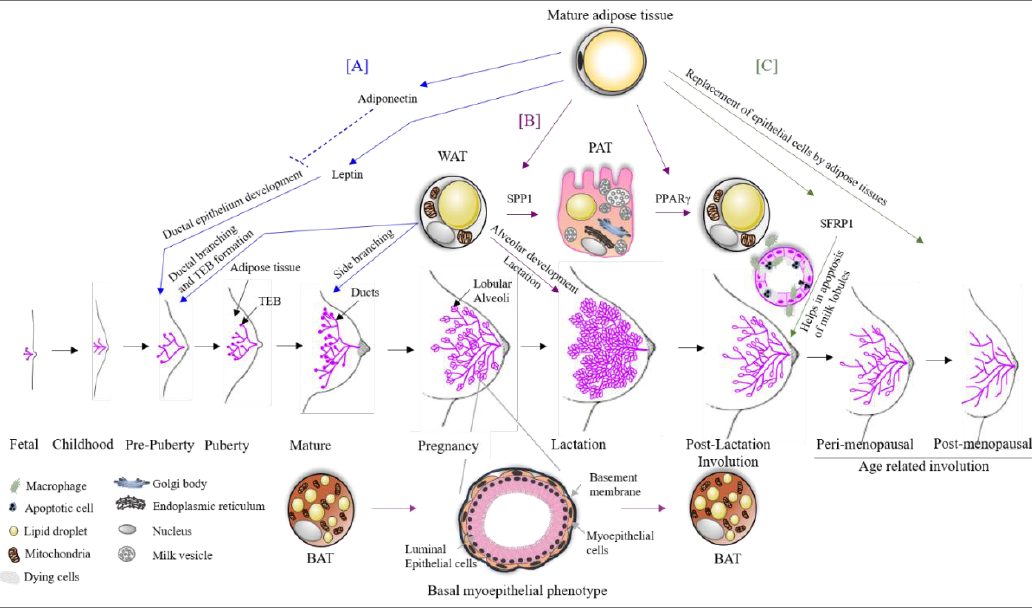
Figure 1. The role of adipose tissue in breast development. ( A ) Mature breast adipose tissue secretes leptin which is essential for ductal epithelial development. High levels of adiponectin inhibit this process. White adipose tissue (WAT) is essential for the formation of terminal end buds (TEBs) during prepuberty and puberty stages. After menarche, the breast starts to mature, and the duct starts its side branching, which requires WAT. ( B ) During pregnancy, WAT trans differentiates into pink adipose tissue (PAT). PAT has milk secretory potential. The process of trans differentiation from WAT to PAT is carried out by the transcription factor SPP1. Moreover, WAT is also essential for alveolar development during the lactation phase and also for the lactation process. During the phase of pregnancy and lactation, brown adipose tissue (BAT) trans differentiates to a basal myoepithelial phenotype helping in the alveolar development. Both trans differentiated cells revert to their original state after lactation with the aid of the transcription factor PPARγ. ( C ) There are two stages of breast involution (i) post-lactation and (ii) age-related. SFRP1 secreted by breast adipose tissue helps in these involution processes by the apoptosis of luminal epithelial cells. Furthermore, the epithelial cells are replaced by adipose tissue during the involution process.